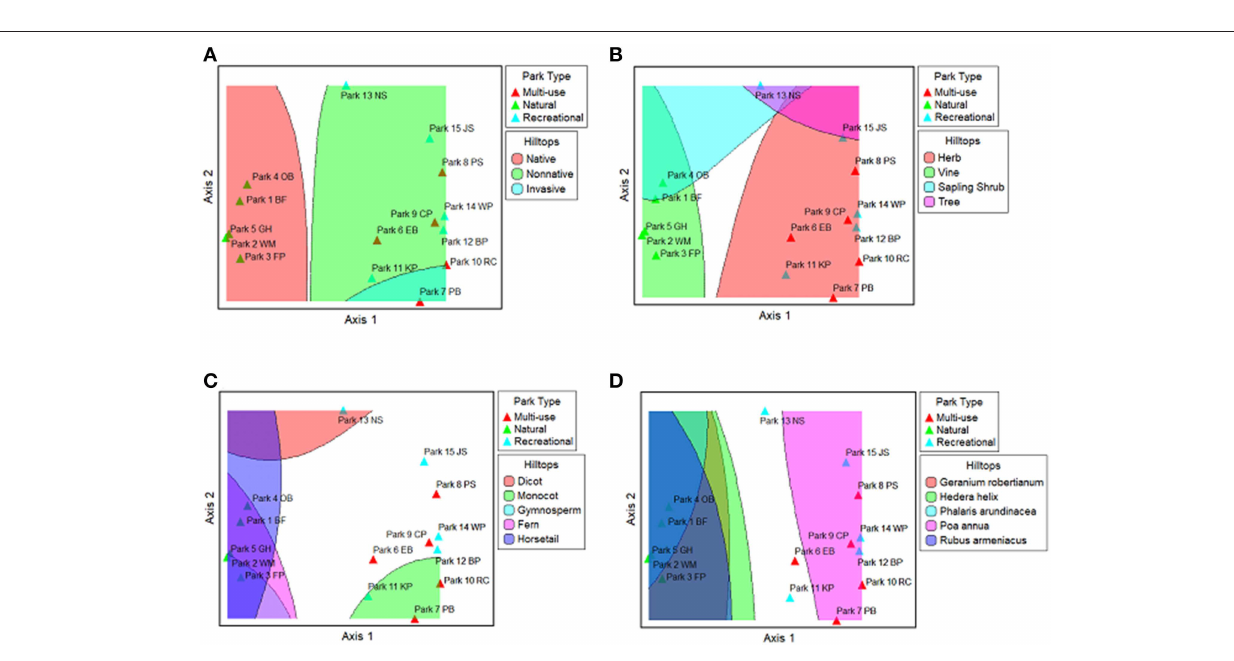
FIGURE 10 | Hilltop plots for the presence/absence NMS ordination. Each colored area is a hilltop that shows the optima of a variable, and the multiple partially transparent hilltops show the overlap of variable optimas for (A) native, non-native, and invasive species, (B) herb, vine, sapling/shrub, and tree strata, (C) dicot, monocot, gymnosperm, fern, and horsetail, and (D) select invasive species. Park code information can be found in the Supplementary Material